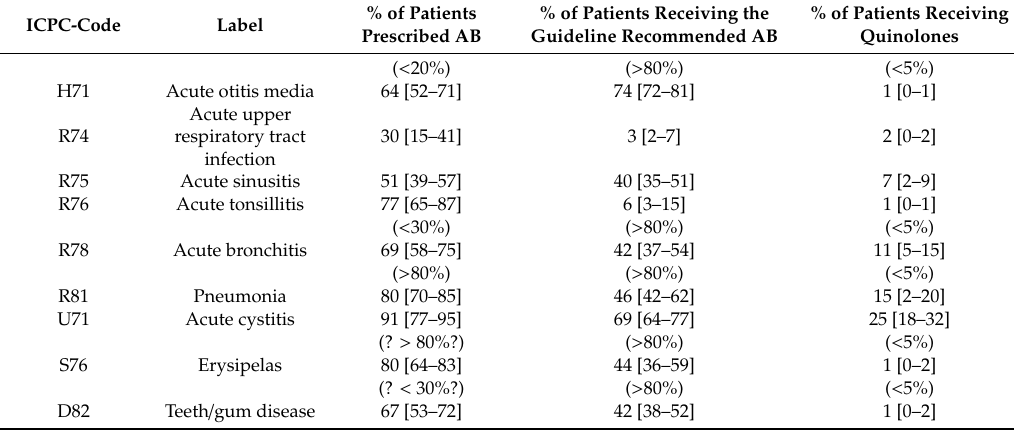
Table 3. Quality appraisal using disease-specific antibiotic prescribing quality indicators (APQI) complemented with self-generated indicators for erysipelas and dental abscess.